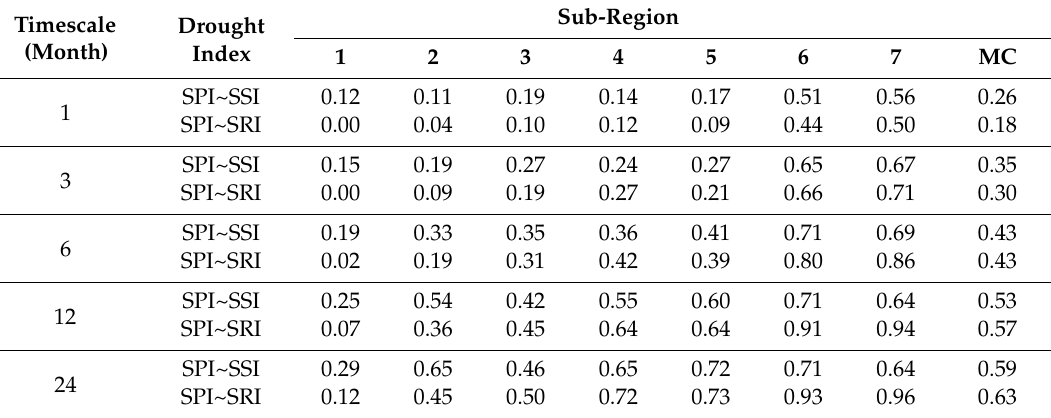
Table 4. The averaged r values of between SPI and SSI (or SRI) at di ff erent timescales in seven sub-regions of China.